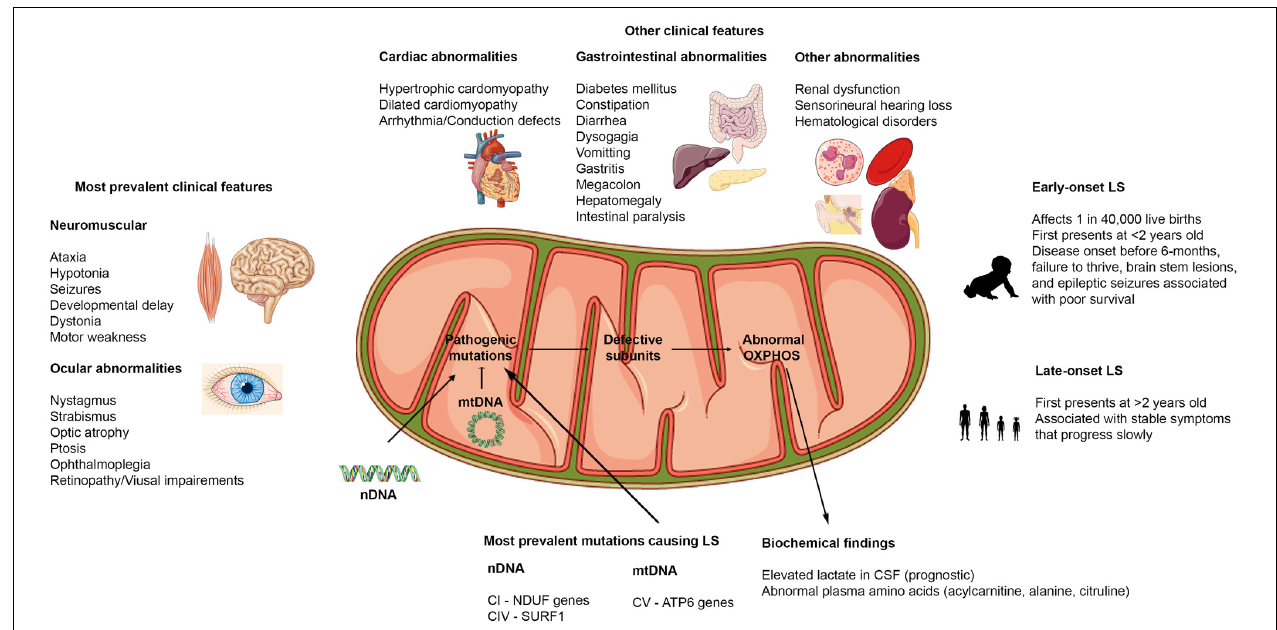
FIGURE 2 | Clinical features of Leigh syndrome. Figure showing the various clinical features associated with LS. The most prevalent clinical features affect the brain, muscles, and eyes. Other clinical findings include dysfunctions in cardiovascular, gastrointestinal, renal, auditory, and hematological systems. LS can present as early onset or late-onset with abnormalities in at least 3 of the organ systems highlighted. LS results from pathogenic mutations in either the nDNA or mtDNA that causes abnormalities in the OXPHOS capacities of the mitochondria. Hence, biochemical findings reflect these defects.